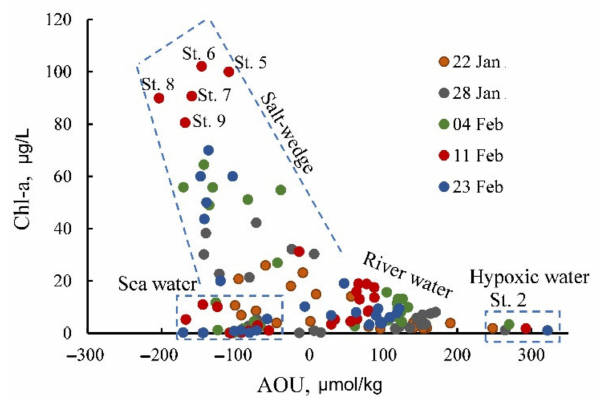
Figure 8. Chl-a vs. AOU